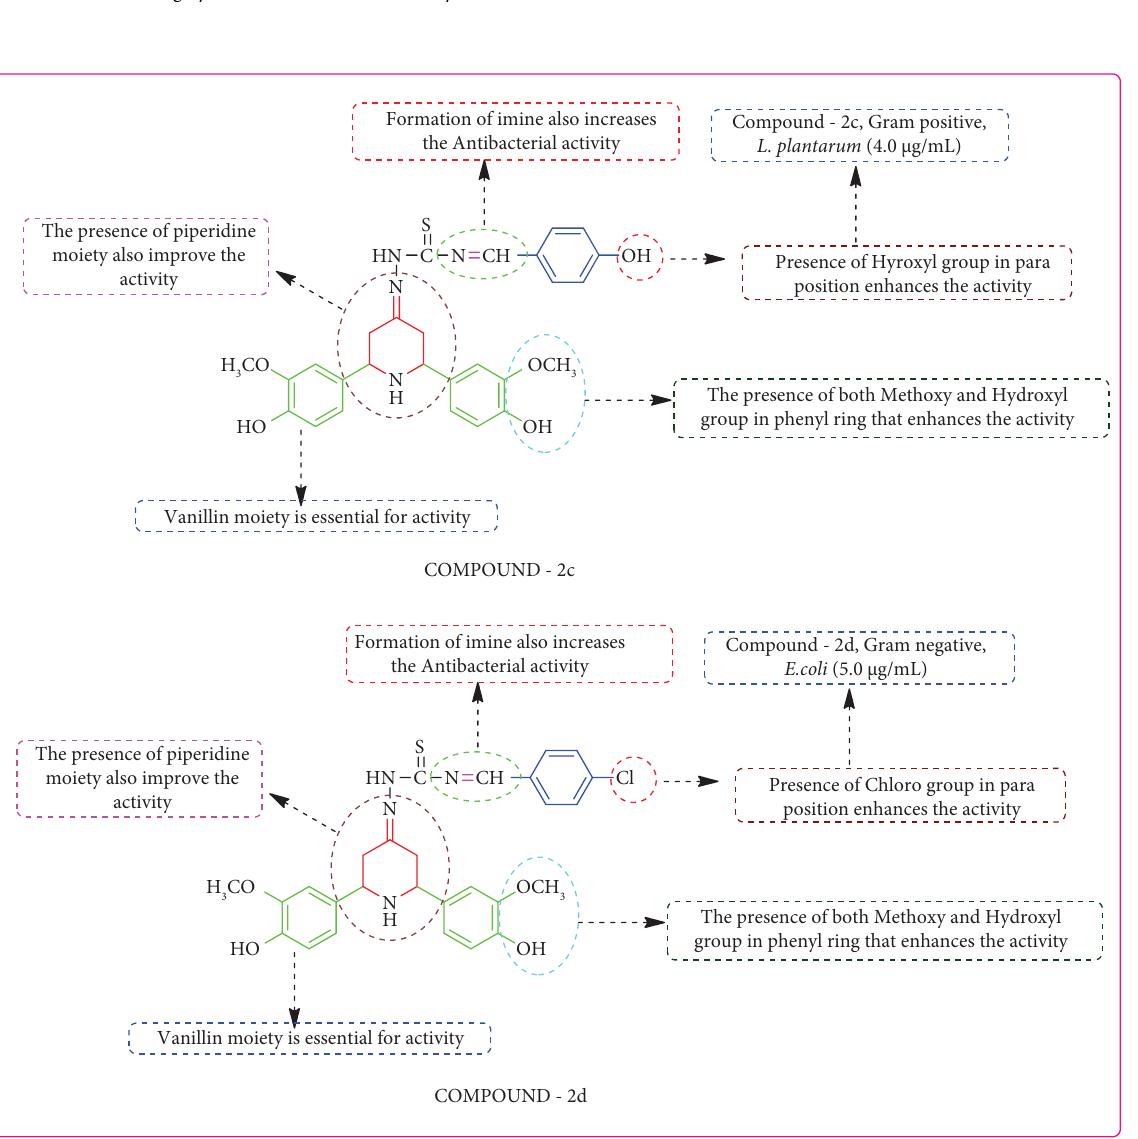
Figure 10: SAR relationship of highly active